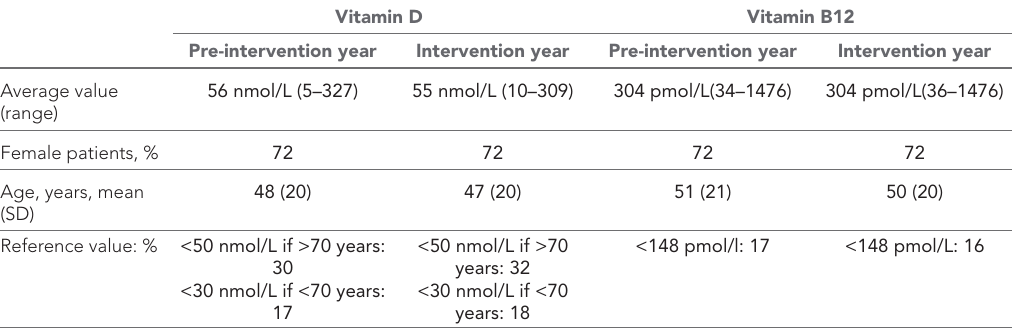
Table 3 Results of ordered vitamin D and B12 tests Vitamin D Vitamin